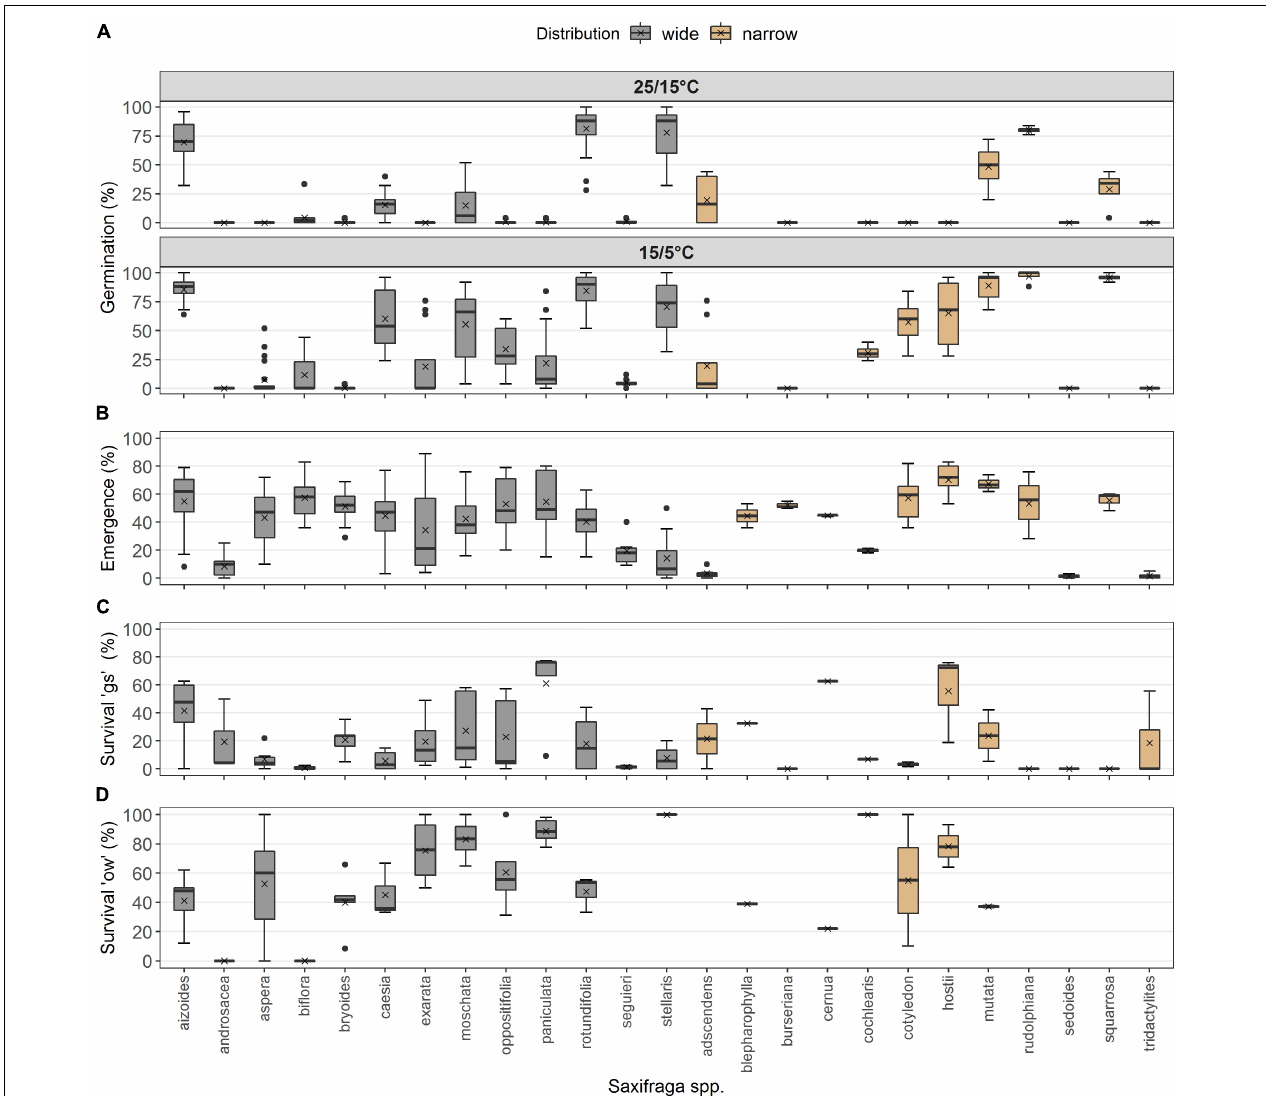
FIGURE 5 | Recruitment responses at species level. (A) Germination percentage under warm and cold laboratory temperature ( N = 584). (B) Emergence percentage in the common garden under natural seasonal climate ( N = 236). (C) Survival percentage “gs” ( N = 79), and (D) survival percentage “ow” ( N = 52). Species are listed in alphabetical order within each distribution. Boxes illustrate the interquartile range with the median as line; whiskers illustrate the minimum and maximum; points denote outliers; x denotes the